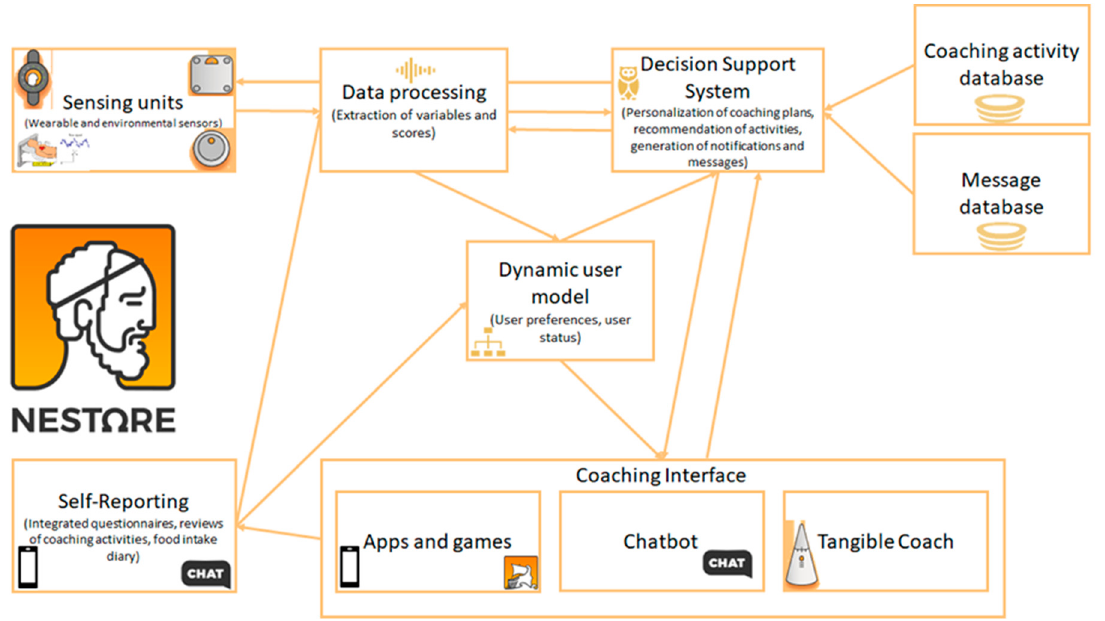
Figure 6. NESTORE e-coaching